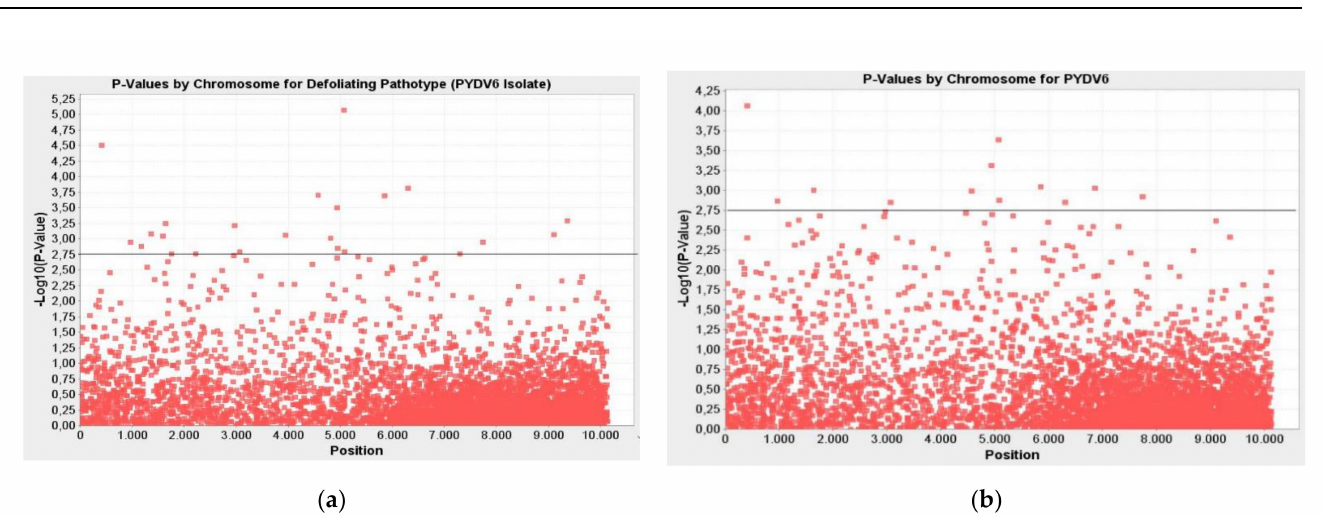
Figure 4. Manhattan plots for markers associated with defoliating pathotype (PYDV6 isolate) of Verticillium wilt disease; ( a ) GLM; ( b ) MLM; the line indicates the significance threshold (-LOG10 ( p -Value) <